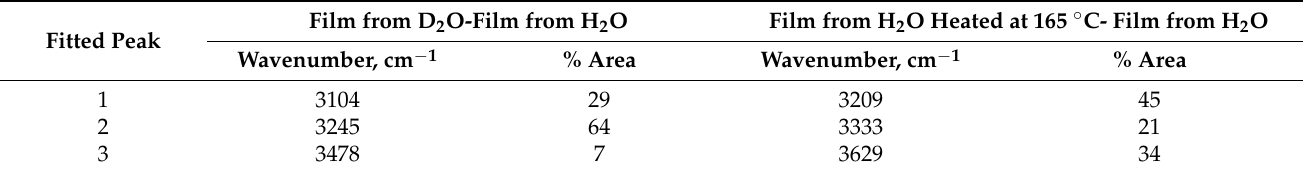
Table 2. Wavenumber and % Area of the fitted peaks presented in Figure